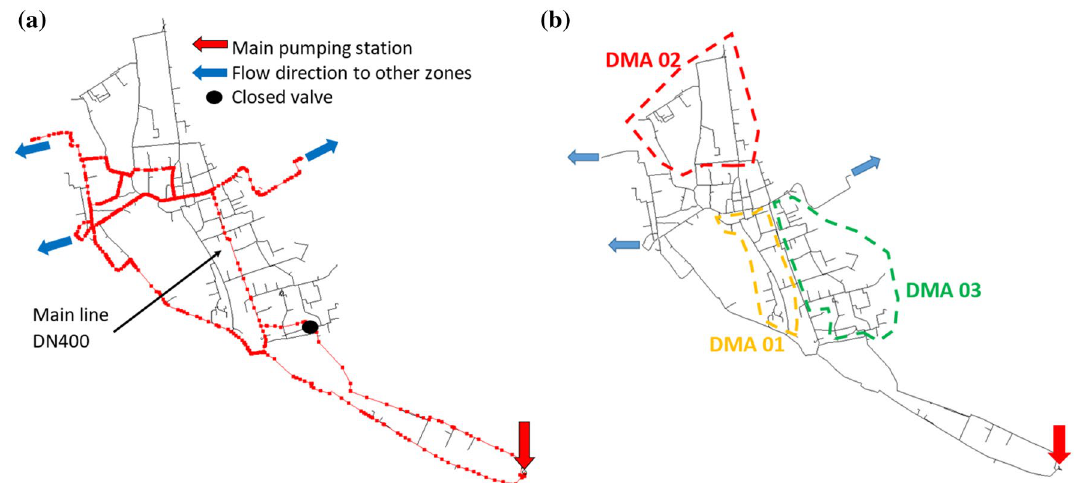
Fig. 2 a “Transmission” pipes and b preliminary division into DMAs